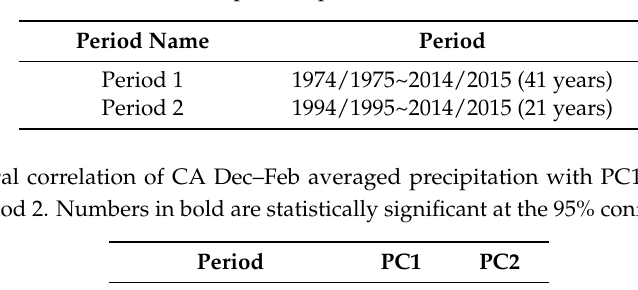
Table 1. Specified periods for research.